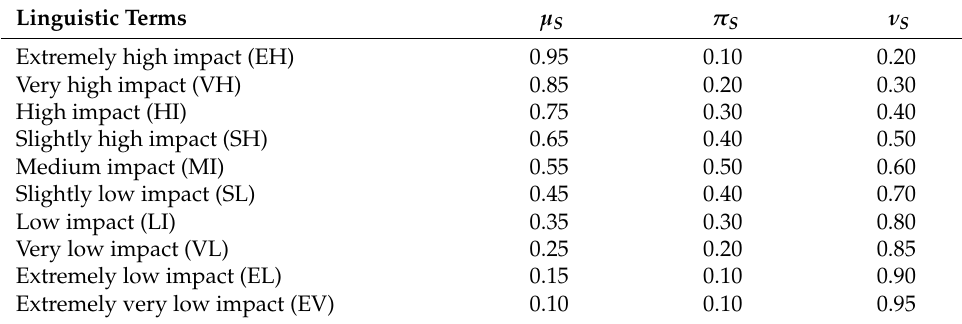
Table 1. Relationship between the linguistic terms and spherical fuzzy numbers.